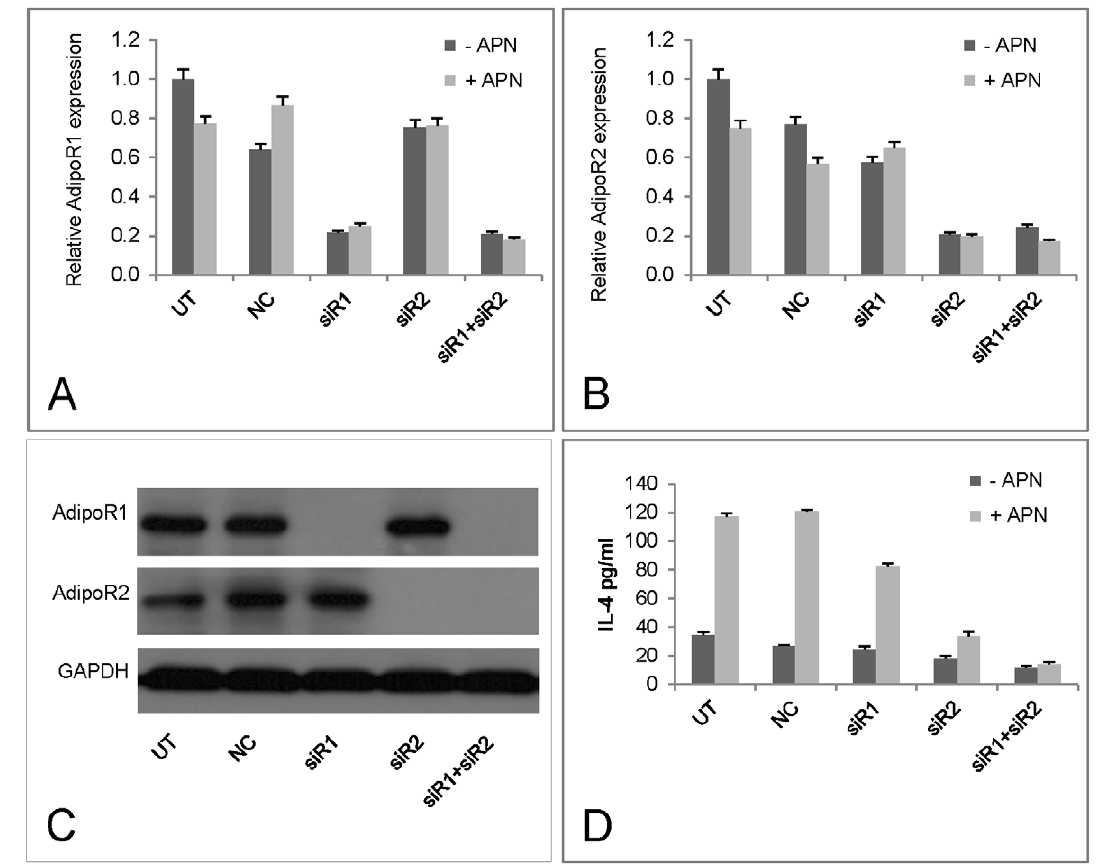
Figure 3. IL-4 production in response to adiponectin receptor AdipoR1 and AdipoR2 knockdown using siRNA. EL-4 cells were transfected with siRNA for AdipoR1 and AdipoR2 for 24 or 48 hours together with control siRNA (n=2). The effects of siRNA were detected both with Q-PCR and Western blot with specific antibodies. Supernatants were collected for the measurement of IL-4 production.